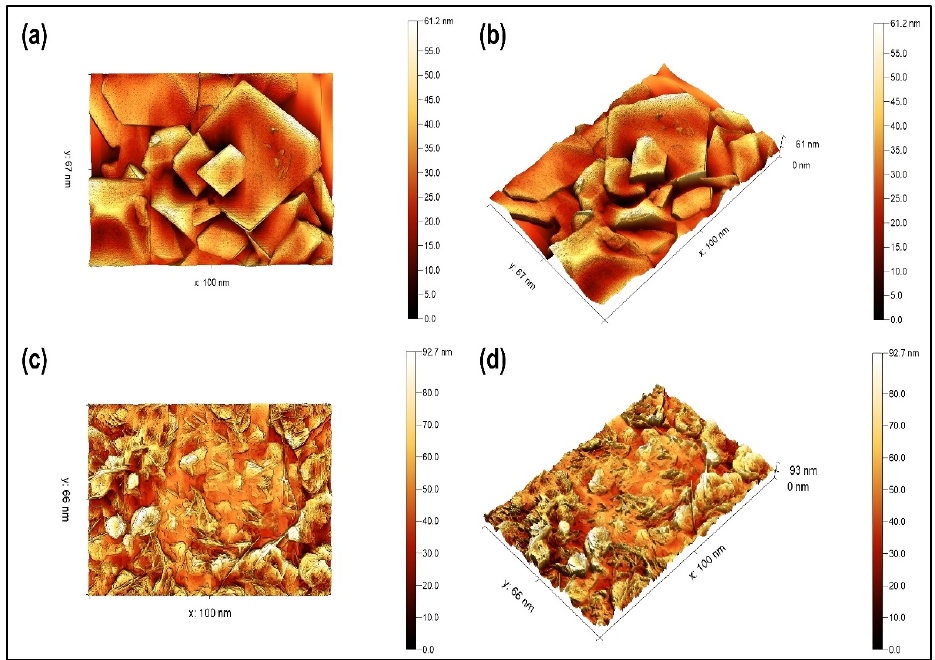
Figure 3. ( a , c ) Two ‐ dimensional AFM images of green synthesized CoFe 2 O 4 nanoparticles and CoFe 2 O 4 /Ca ‐ Alg nanocomposite, respectively; ( b , d ) 3D AFM images of green synthesized CoFe 2 O 4 nanoparticles and CoFe 2 O 4 /Ca ‐ Alg nanocomposite,